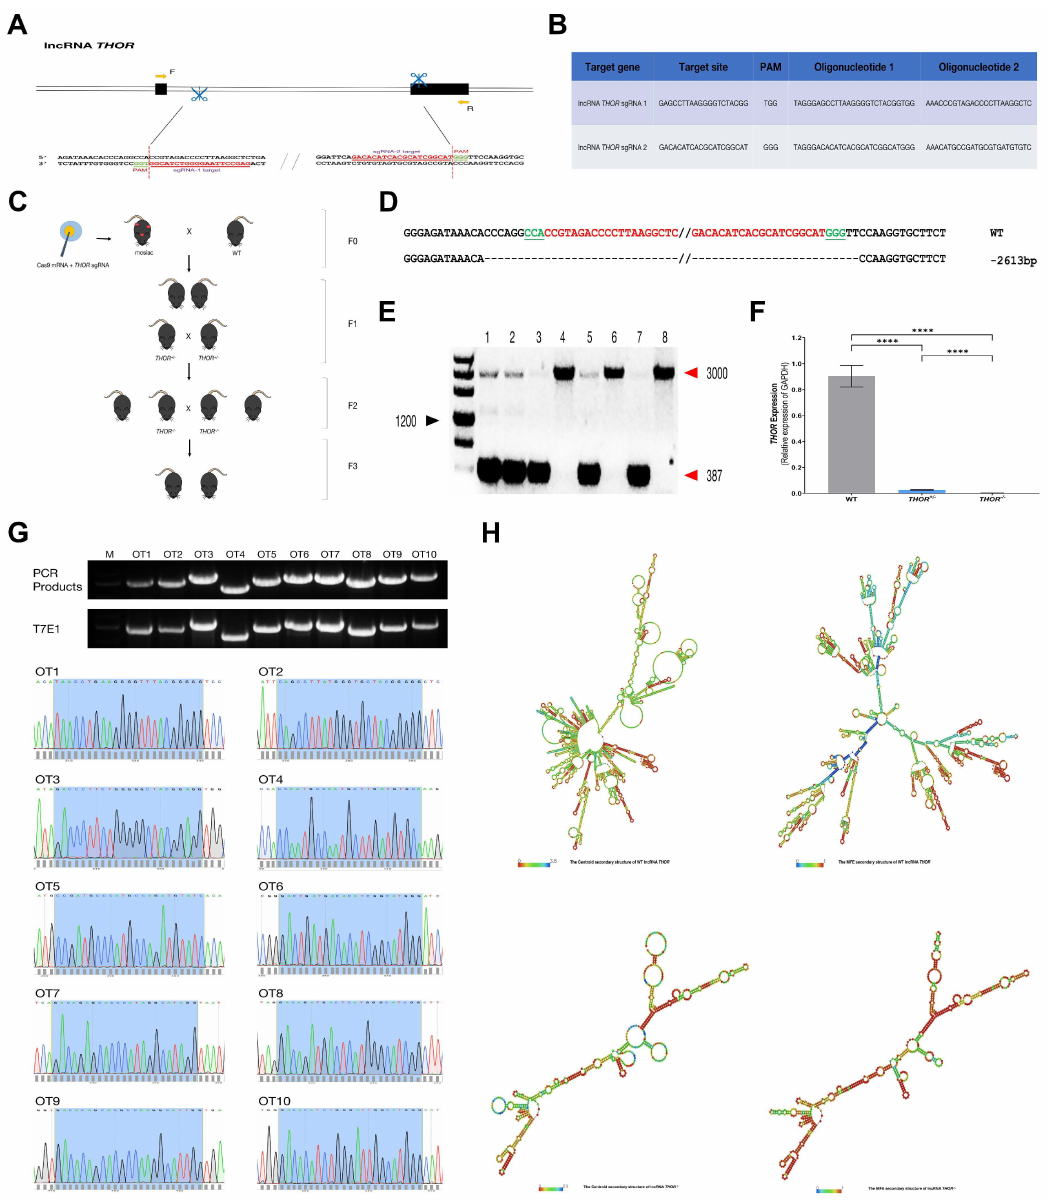
Figure 2. Generation of lncRNA THOR -deficient mice. ( A ) Schematic diagram of the sgRNA targeting of the mouse THOR gene locus. THOR exons are indicated by rectangles, the target sites of the 2 sgRNA sequences (sgRNA 1 and sgRNA 2) are highlighted in red, and the protospacer-adjacent motif (PAM) sequence is highlighted in green. Primers F and R were used to detect mutations in mice. ( B ) Target sequences of the two sgRNAs and complementary oligo sgRNAs. ( C ) Schematic depicting the creation of the THOR -deficient mouse model. ( D ) THOR mutation detection in mice by T-cloning and Sanger sequencing. ( E ) PCR analysis of THOR mutations in pups (M) D2000; 1–8 represent the newborn mice used in this study. ( F ) Mutations in 8-week-old THOR +/− and THOR −/− were detected by qRT-PCR. Compared with that in the WT control group, the expression of THOR in THOR -deficient mice was significantly decreased. **** indicates p ≤ 0.0001 as determined by a t -test. The data are shown as the mean ± SD from two independent experiments. ( G ) Detection of off-target effects in THOR -deficient mice. T7E1 cleavage analysis of three potential off-target sites (POTS) for sgRNA 1, M, DL2000; 1–3 represent the three POTS. T7E1 cleavage analysis of seven POTS for sgRNA 2, M, DL2000; 4–10 represent the seven POTS. T-cloning and Sanger sequencing of the three POTS for sgRNA1. The region including the 20 bp of the POTS and the PAM is shown in the shadow. T-cloning and Sanger sequencing of the seven POTS for sgRNA 2. The region including the 20 bp of the POTS and the PAM is shown in blue. ( H ) The centroid and MFE secondary structures of THOR and THOR −/− mice were predicted (http://rna.tbi.univie.ac.at/ accessed on 1 July 2021). The red color indicates strong confidence for the prediction of each base.